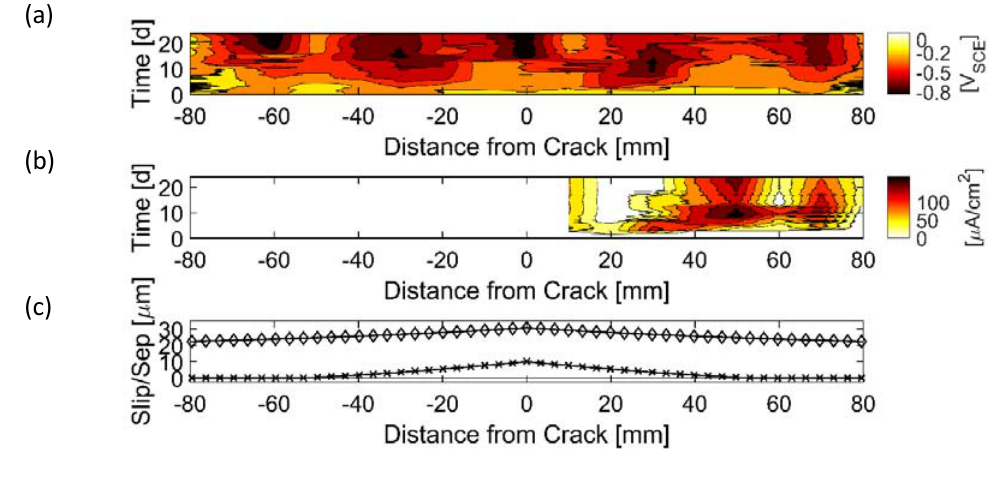
Figure 6. Location and time ‐ dependent (a) open circuit potential, (b) corrosion current density (bottom), and (c) interfacial damage for specimen with crack width of 0.14 mm. After